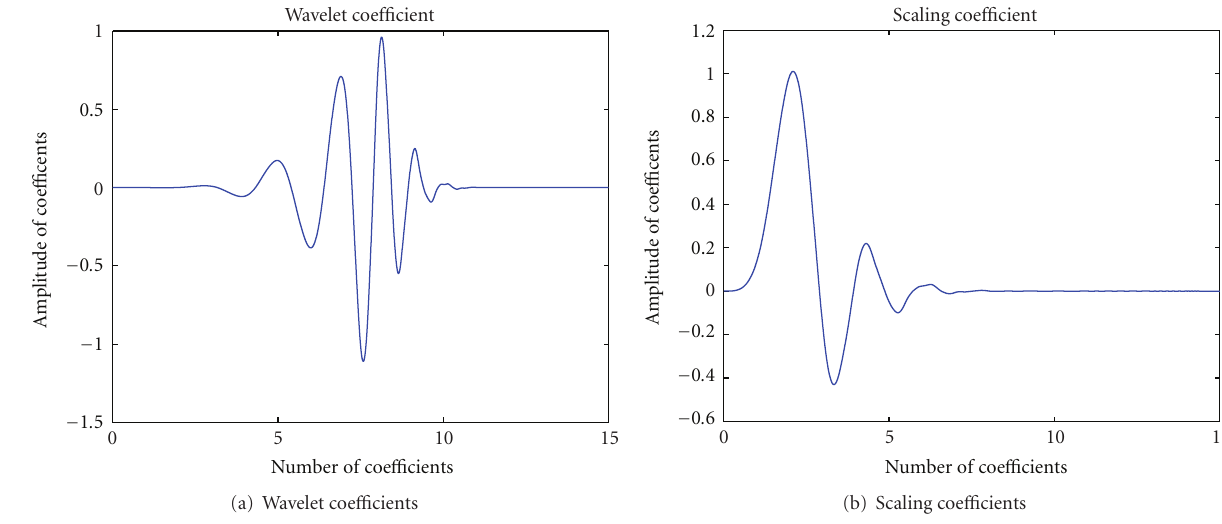
Figure 4: Daubechies wavelet and scaling coe ffi